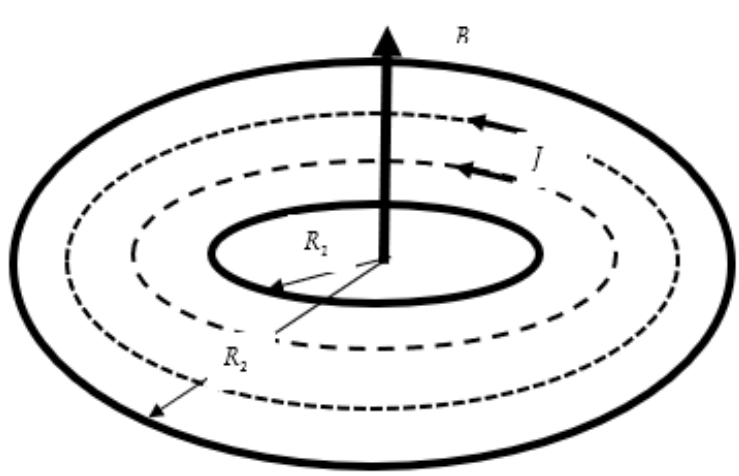
Figure 1. Thin disk coil carrying the constant azimuthal current density, J .